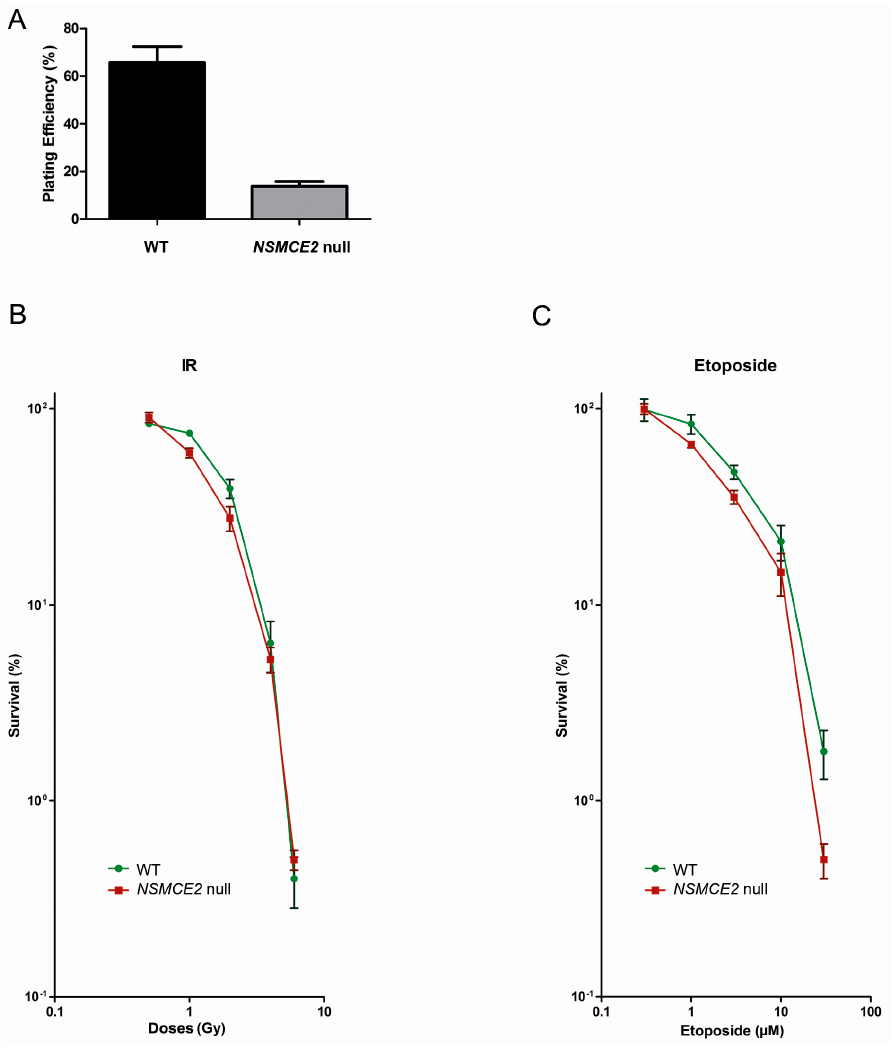
Figure 5. Absence of NSMCE2 affects survival upon etoposide-induced DSBs. ( A ) Plating efficiency of WT and NSMCE2 null cells during clonogenic assays. The survival capacity of plated cells under non-challenged conditions was reduced in NSMCE2 null cells compared to WT. Data are presented as mean ± SEM, n = 8; ( B ) Clonogenic assay after increasing doses of IR. NSMCE2 null cells seemed to be slightly more sensitive to IR than WT cells ( p > 0.05). Data are presented as mean ± SEM, n = 3; ( C ) Clonogenic assay after increasing doses of etoposide. NSMCE2 null cells were significantly more sensitive to etoposide than WT cells. Data are presented as mean ± SEM, n = 3.